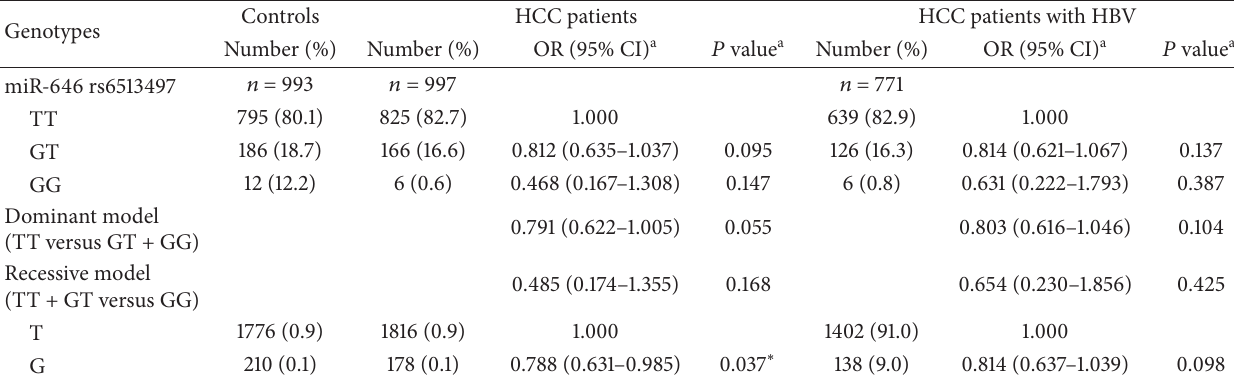
Table 2: Association between genotypes/alleles of miR-646 rs6513497 and the risk of